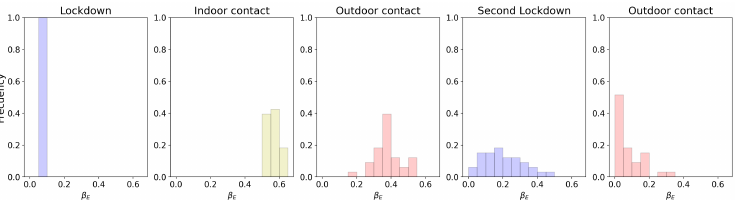
Figure 15. Histogram of the 33 different regions of Germany. The value of β E at the different levels of lockdown registered in